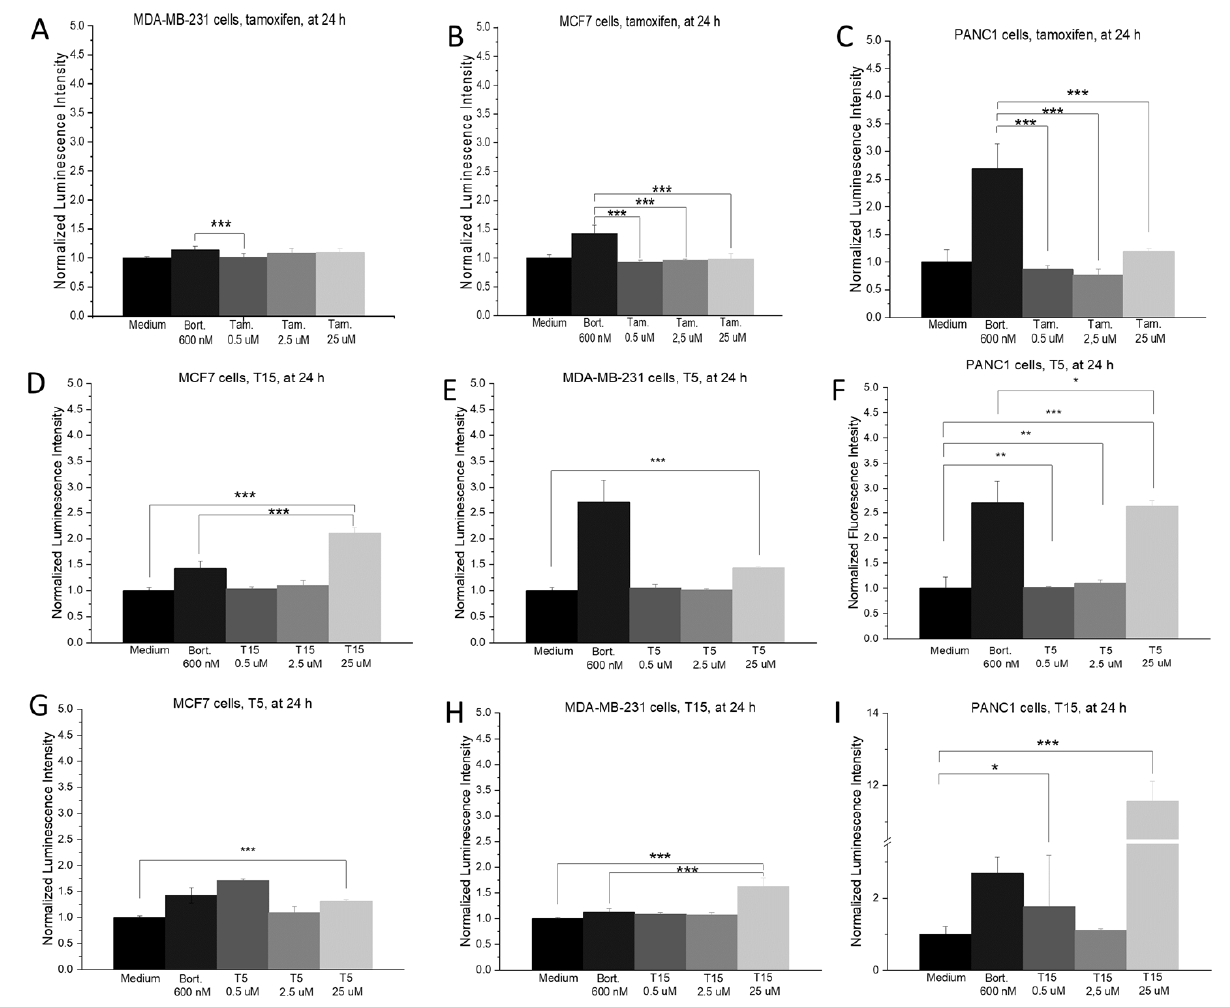
Figure 5. Impact of tamoxifen ( A ): MCF7, ( B ): MDA-MB-231, ( C ): PANC1), T5 ( D ): MCF7, ( E ): MDA-MB-231, ( F ): PANC1) and T15 (( G ): MCF7, ( H ): MDA-MB-231, ( I ): PANC1) on the ROS production